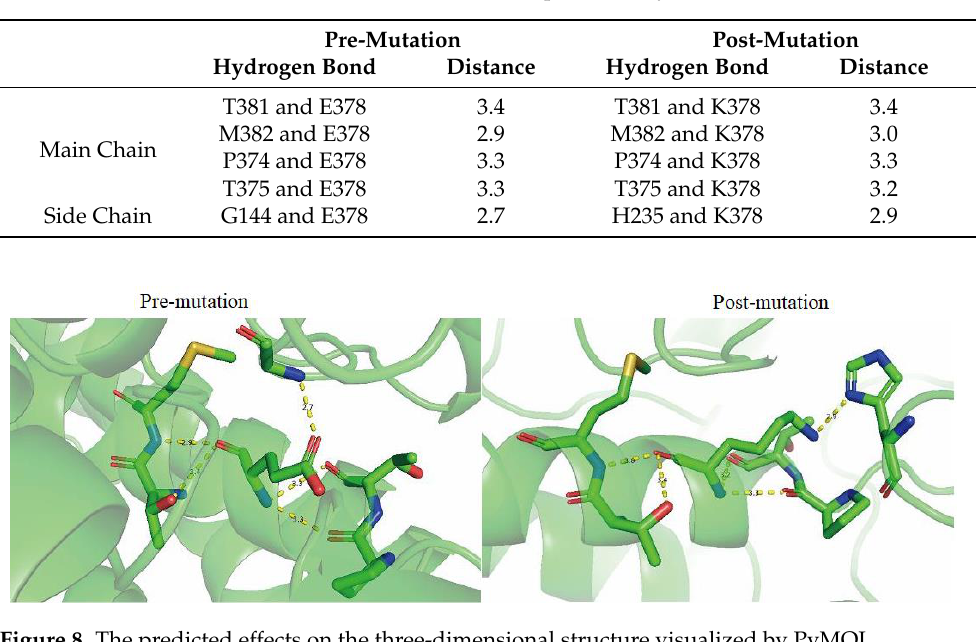
Table 2. The effects on the three-dimensional structure predicted by the tool SWISS-MODEL.